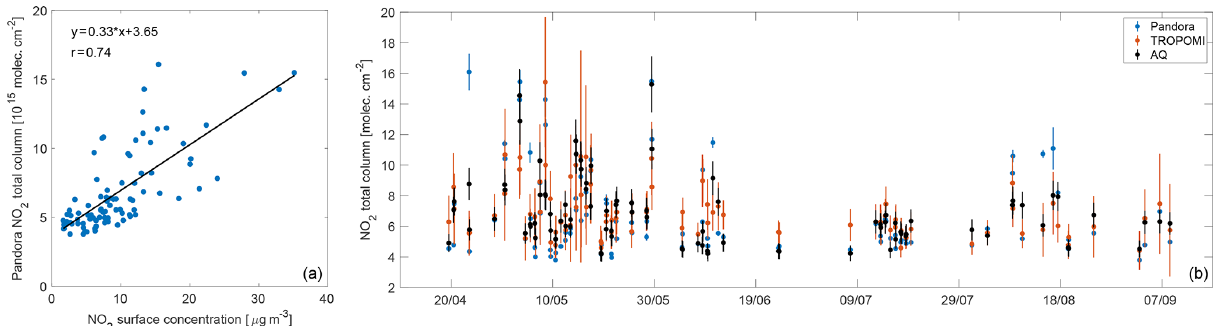
Figure 6. (a) Scatterplot of Pandora total columns and surface concentration data. (b) Time series of NO 2 total columns from Pandora (blue), TROPOMI (red) and Kumpula AQ station (black) at the satellite overpass time. The surface concentrations are empirically converted to total columns using the results of the linear regression between Pandora total columns and surface concentration data (a) .